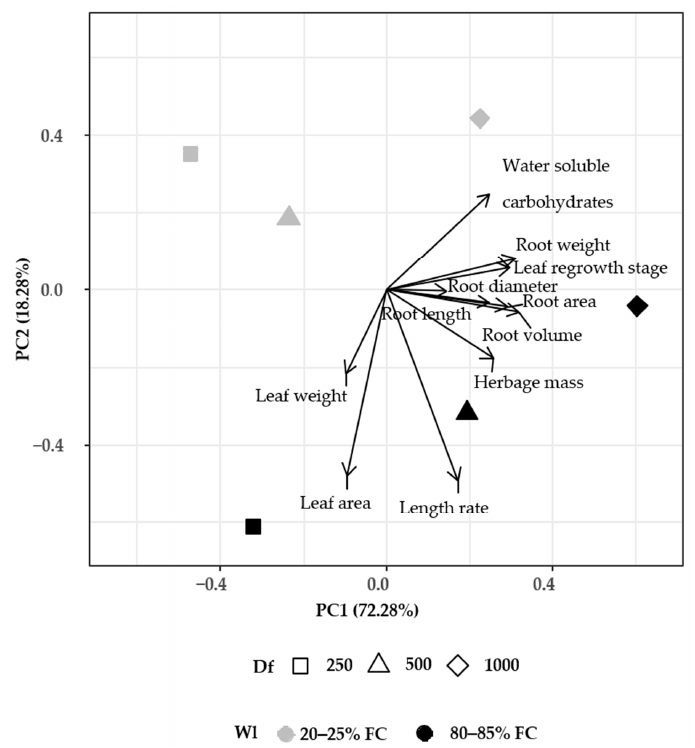
Figure 2. Principal component analysis showing changes in the growth variables and their relationship for Bromus valdivianus Phil. due to defoliation frequency (Df) based on accumulated growing degree days: 250 (high) ( (cid:3) ), 500 (medium) ( (cid:52) ) and 1000 (low) ( ) accumulated growing degree days, (cid:51) and two levels of soil-water restriction (Wl): 80–85% field capacity (FC) (shaded black) and 20–25% FC (shaded